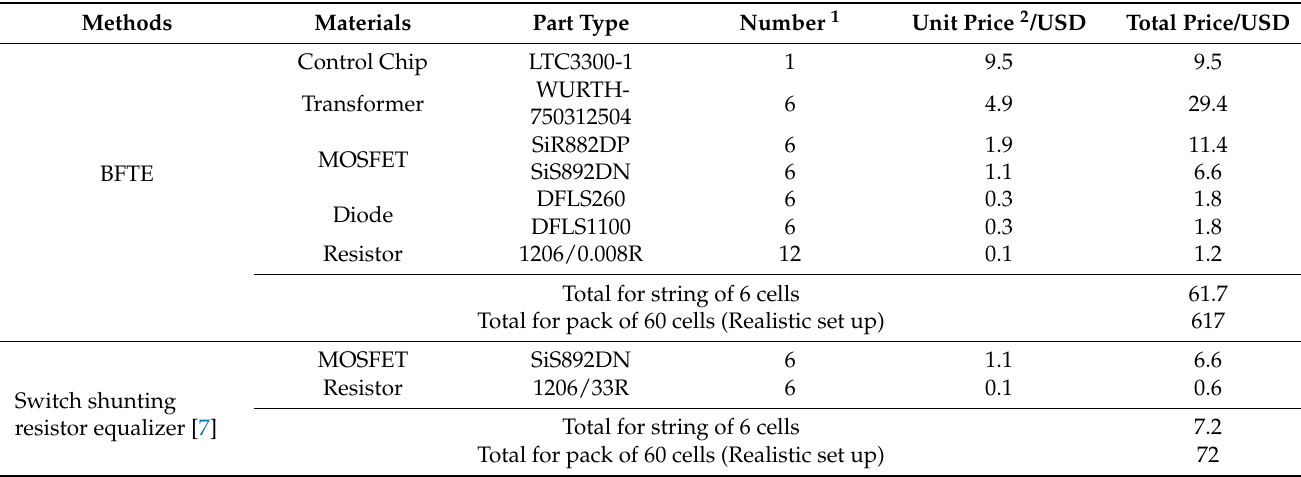
Table 8. Implementation cost of BFTE and switch shunting resistor